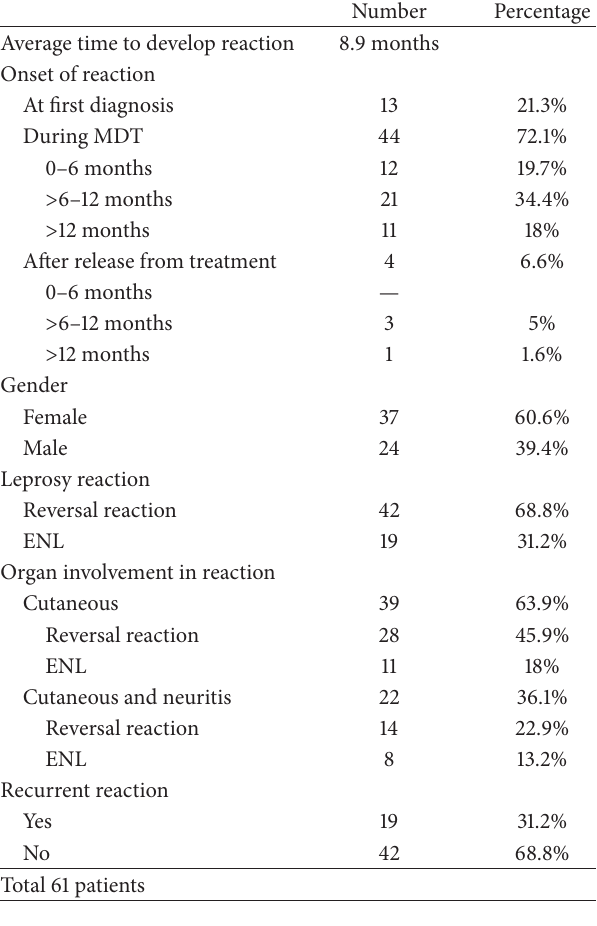
Table 2: Characteristics of leprosy reactions.